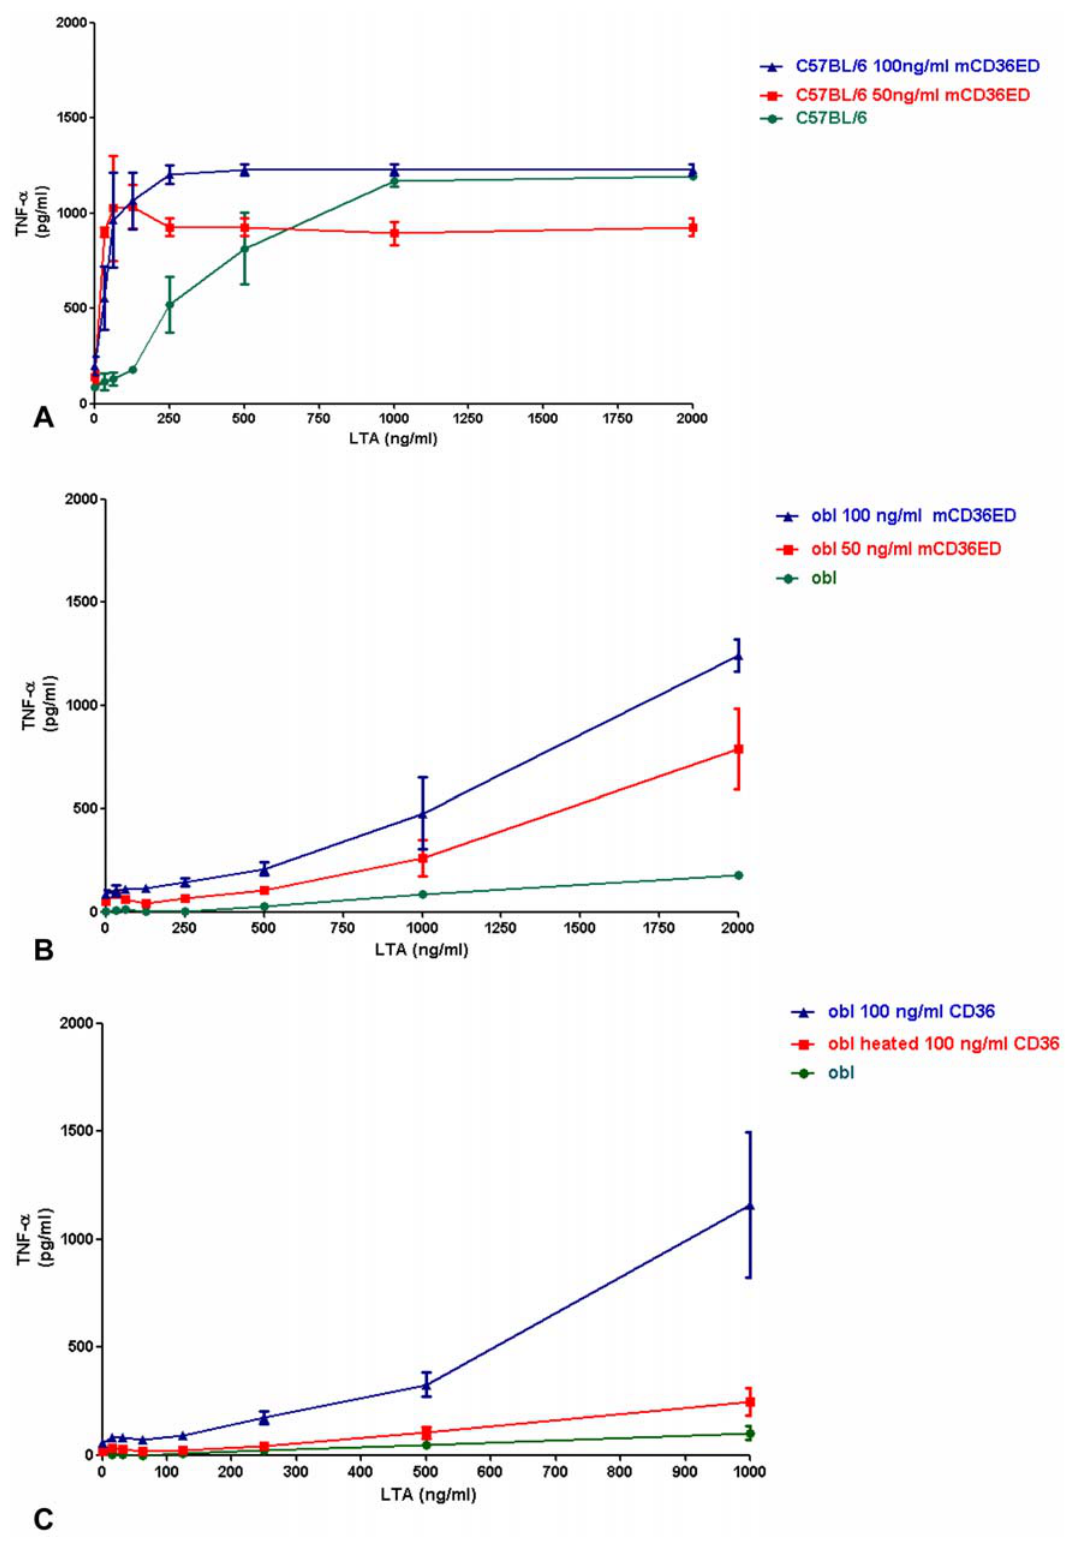
Figure 4. TNF- a secretion by macrophages with LTA. ( A ) mCD36ED increases secretion of TNF- a by low LTA concentrations in C57BL/6 macrophages. ( B ) mCD36ED restores secretion of TNF- a in oblivious (obl) macrophages. ( C ) Denatured mCD36ED did not restore secretion of TNF- a by oblivious (obl) macrophages. Macrophages from C57BL/6 and oblivious were exposed to different concentrations of LTA plus a constant amount of mCD36ED, or heated denatured mCD36ED (for oblivious macrophages) for 4 hours at 37 u C. The amount of TNF- a secreted to the supernatant was determined by L929 cytotoxic assay. Values are expressed as mean values + / 2 _SEM (n=3 mice).